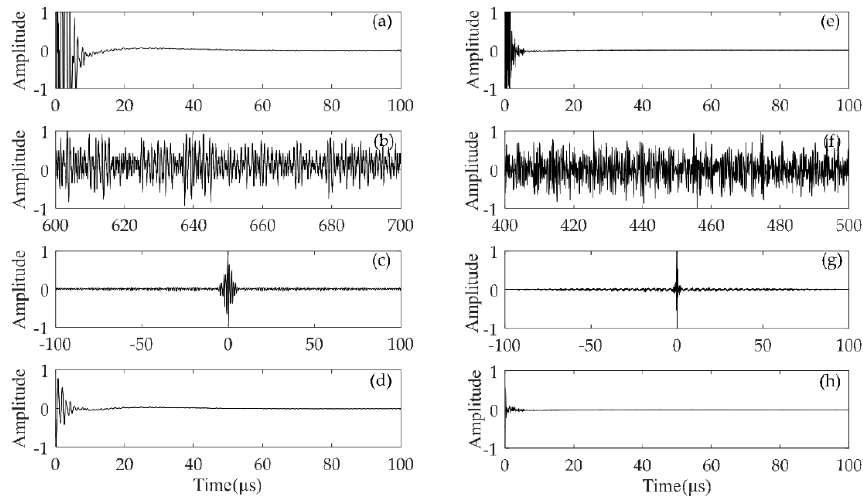
Figure 5. ( a – d ) are normalized signals for i = j = 8 corresponding to the full matrix, h i , j ( t ) , d i , j ( t ) , g i , j ( t ) , and f i , j ( t ) with a 1.0 MHz excitation frequency and 16 elements. ( e – h ) are normalized signals for i = j = 16 corresponding to the full matrix, h i , j ( t ) , d i , j ( t ) , g i , j ( t ) , and f i , j ( t ) with a 2.5 MHz excitation frequency and 32 elements.